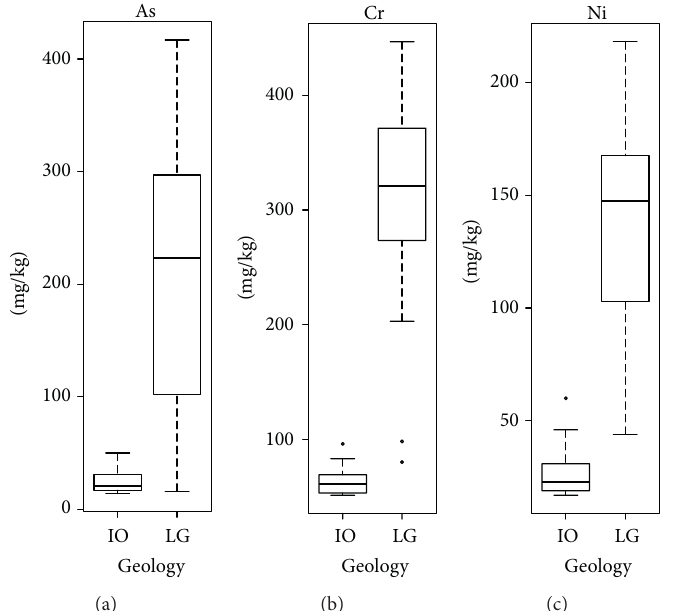
Figure 2: Box and Whisker plots for total As, Cr, and Ni concentrations stratified by geology; “IO” represents the Inferior Oolite Group and “LG” represents the Lias Group. The bar shows the median